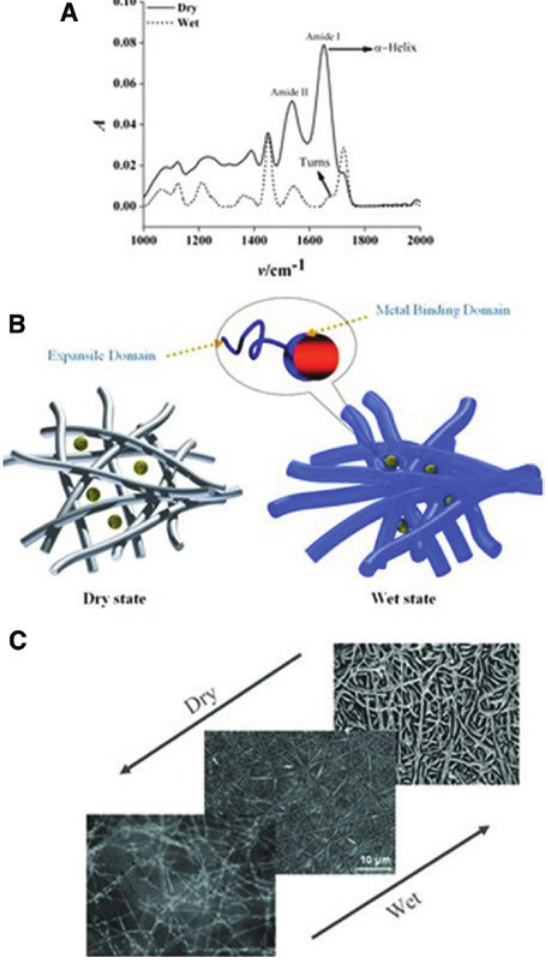
Figure 13: (A) Fourier transform infrared spectroscopy spectra of the BSA/PANGMA ENMs as dry (the solid upper line) and wet (the dashed lower line). (B) The sketch illustrates how the swollen functionalized nanofibers capture the nanoparticles. (C) The optical images show morphological change of the membrane and the reversible swelling of the functionalized nanofibers in wet and dry states implying a smart-performing membrane. For details, see Ref. [54]; reprinted with permission from Wiley.